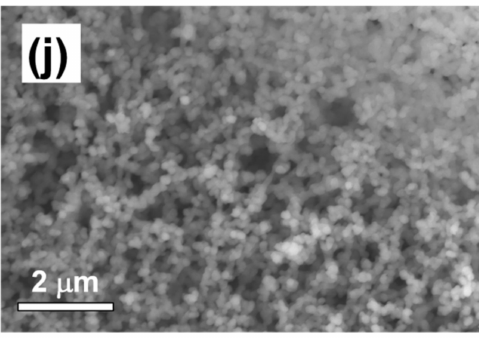
Figure 4. SEM images of 50 PEDOT/GtPU, 110 PEDOT/GtPU, 50 PEDOT/GnPU, 110 PEDOT/GnPU composite sponges under differing levels of magnification. ( a , b ) for 50 PEDOT/GtPU, ( c – e ) for 110 PEDOT/GtPU, ( f , g ) for 50 PEDOT/GnPU, ( h – j ) for 110